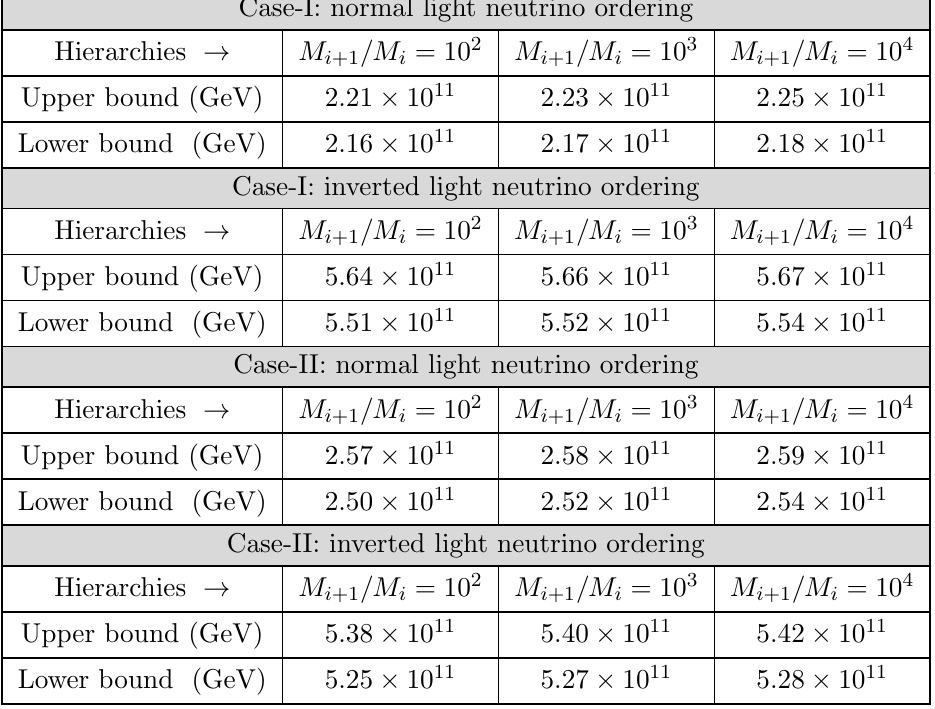
Table 9 . Lower and upper bounds on M 1 for di(cid:11)erent mass ratios of the RH neutrinos ( i = 1 ; 2). j = 3 term of the (cid:12)rst term of eq. (6.1) has a negligible e(cid:11)ect on " (cid:11) than M and f; d and d have values of the order of the other Dirac components. Now 1 1 2